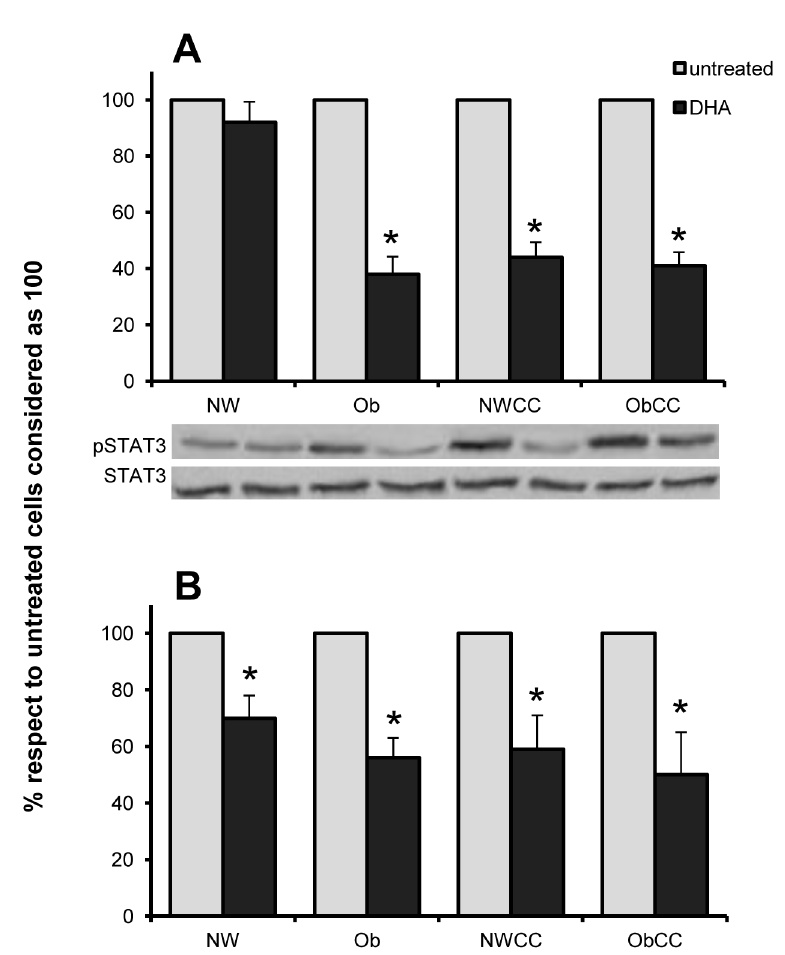
Figure 3. Immunoblotting analysis of pSTAT3, and evaluation of IL-6 secretion after DHA treatment. A : Human visceral adipocytes, collected from the four groups of subjects, were serum-starved for 18 h. Whole cell extracts were separated by SDS- PAGE and analyzed using anti-pSTAT3 antibody. Results were normalized to STAT3 protein content. The data are expressed as means ± SEM. Representative blots are shown. B : IL-6 release was evaluated in the culture media by Elisa as described in Materials and